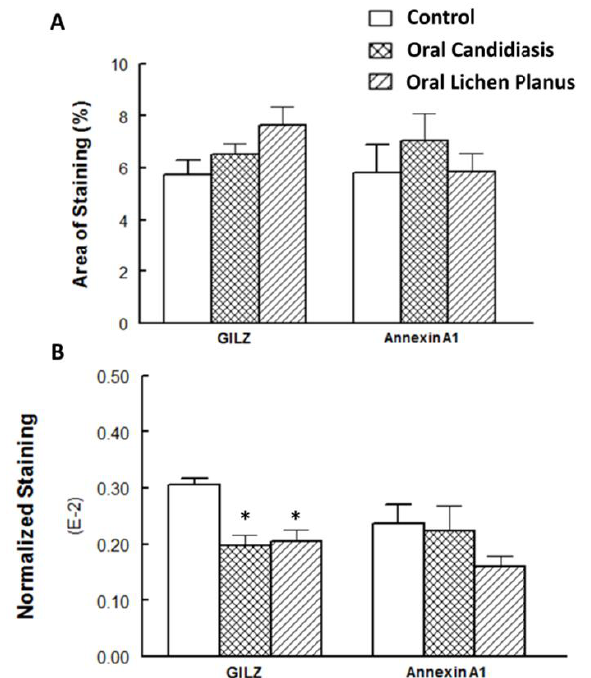
Figure 5. Panels show GILZ and Annexin A1 staining for one tissue sample from control, oral candidiasis, and oral lichen planus groups at higher magnification to better illustrate staining patterns. While GILZ immunostaining is confined to nuclei, Annexin A1 immunostaining is seen for nuclei, cytoplasm, and cell membrane. Further, sparring of Annexin A1 immunostaining is seen for basal layers of epithelium, although less discernable for OLP but more prominent for OC, compared to control, specimens. Scale bar: 50 μm.